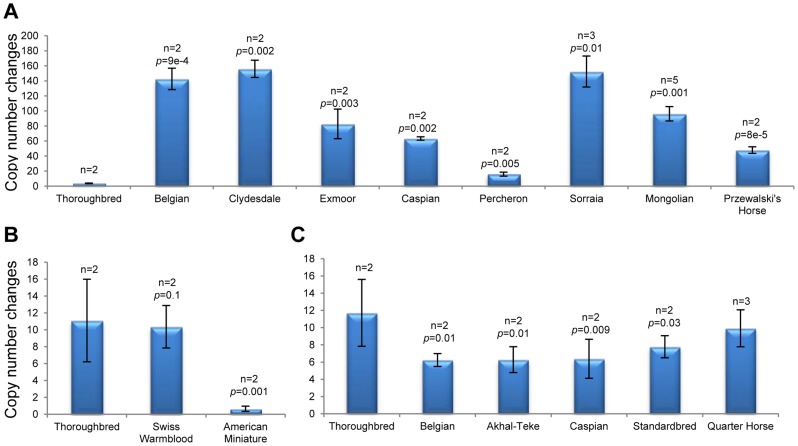
Validation of CNVRs by PCR.
A. gains and B. losses in Chr27 (37.3 Mb; probe Gs_27_37371896) involving CUB and Sushi multiple domains 1 (CSMD1) gene; C. Loss in Chr20 (24.8 Mb; probe Eic_20_24841849) involving olfactory receptors; n – number of individuals analyzed.